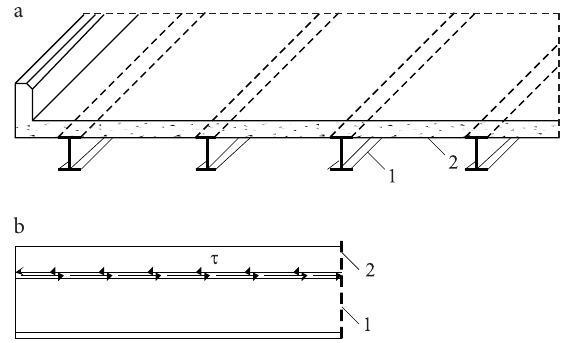
layersa Fig. 1. The scheme of the composite steel-concrete floor: a – general view; b – longitudinal section of the beam; 1 – steel beam; 2 – concrete slab; τ – shear between the